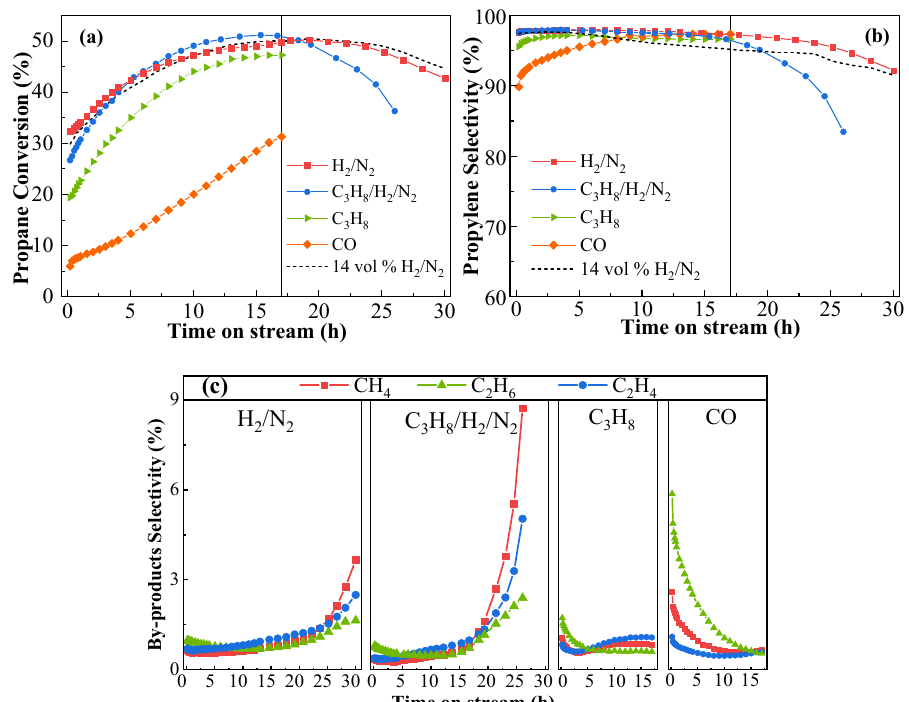
Figure 1. Catalytic performances of PtIn/MAZ catalytic system reduced with different atmospheres: ( a ) propane conversion; ( b ) propylene selectivity; ( c ) by-product selectivity (reduction conditions: T = 600 °C, t = 2.5 h; reaction conditions: T = 600 °C, weight hourly space velocity (WSHV) = 3 h − 1 , atmospheric pressure in the gas mixture of C 3 H 8 :H 2 :N 2 molar ratio = 8:7:35; reaction time: 30 h for H 2 /N 2 and 14 vol % H 2 /N 2 reduced catalyst, 26 h for C 3 H 8 /H 2 /N 2 ‐ reduced catalyst, 17 h for C 3 H 8 and CO ‐ reduced catalyst).